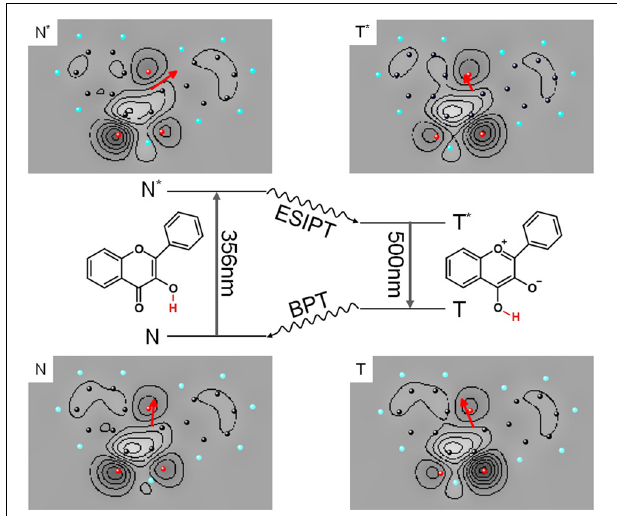
FIGURE 5 | Photocycle of 3-Hf starting with electronic excitation of the normal form (N to N*) followed by ESIPT, continued by radiative decay (T ∗ to T) and finished by BPT. The charge density of the four configurations of 3-Hf are depicted as contour plots and the corresponding electric dipole moment is added as red arrow which shows value (length) and orientation